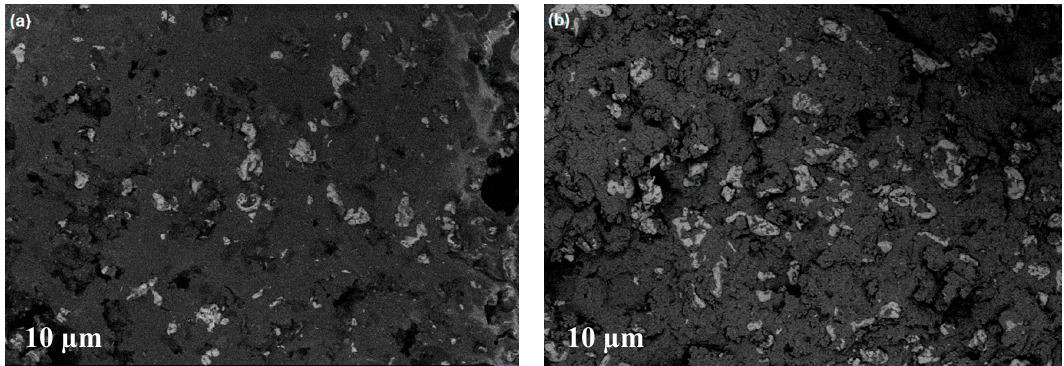
Figure 7. SEM images of the inner surface (height = 0.8 mm) of the composites A ( a ) and B ( b ).